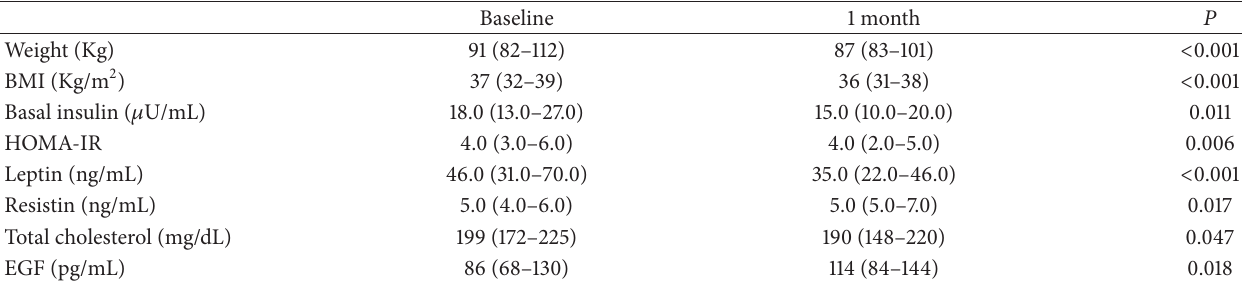
Table 3: Significant variations of anthropometric, clinical, and biochemical features of obese patients after one month of calorie restriction. Baseline 1